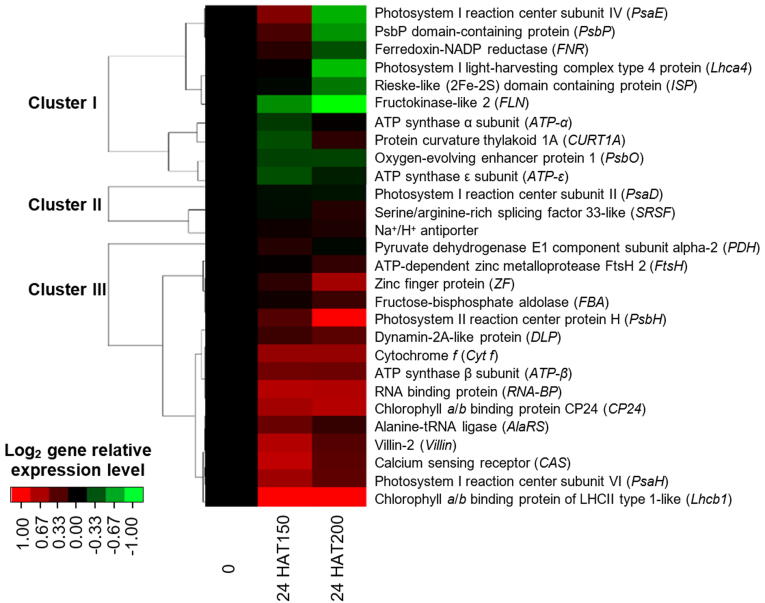
A list of MS/MS spectra of phosphopeptides derived from alkaligrass leaf phosphoproteins